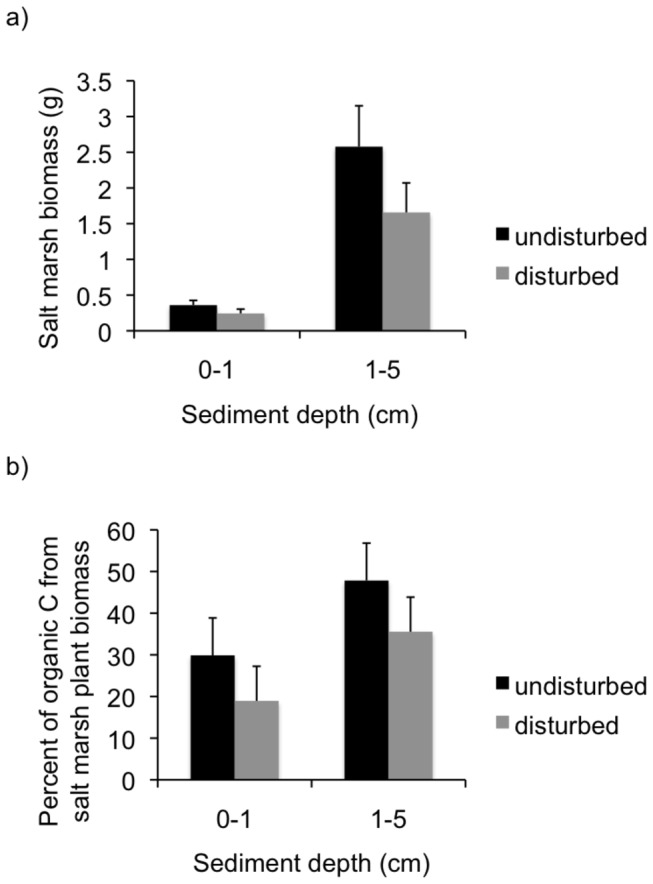
The amount of salt marsh plant material (mean + standard error) in sediments from disturbed and undisturbed plots.Sediment cores were sectioned into 2 depths and all plant material was quantified to determine its contribution to the organic carbon content of the sediments. a) Absolute biomass of salt marsh (

Spartina

alterniflora
) in sediment cores from disturbed and undisturbed plots at two depth intervals. Plant biomass was higher in the 1-5cm depths than in the surface sediments. b) Percentage of organic carbon (C) in each sediment core resulting from salt marsh plant biomass in disturbed and undisturbed salt marsh sediments.